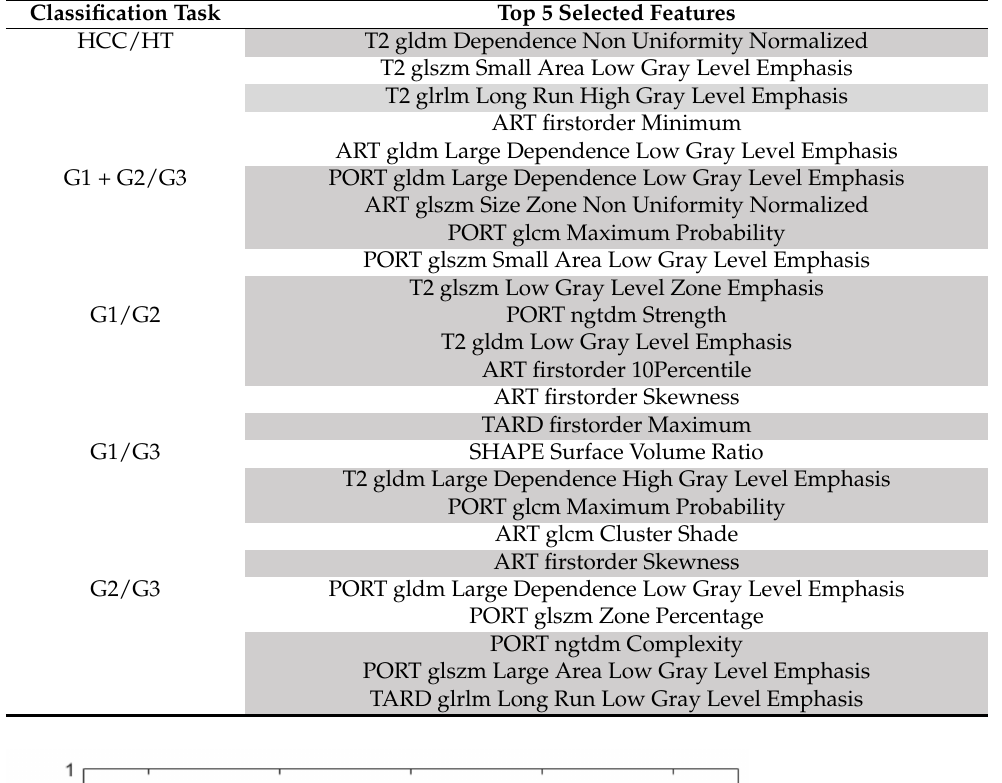
Table 2. Top 5 selected features on the basis of the Mutual Information metric, for each classification task. In grey the features contributing to building the most powerful models. Abbreviations: HCC, hepatocellular carcinoma; HT, normal liver parenchyma; G1, well-differentiated HCC; G2, moderately differentiated HCC; G3, poorly differentiated HCC; T2, features extracted from T2 images; ART, features extracted from arterial post-contrast phase of DCE-MRI; PORT, features extracted from portal post-contrast phase of DCE-MRI; TARD, features extracted from tardive post-contrast phase of DCE-MRI.